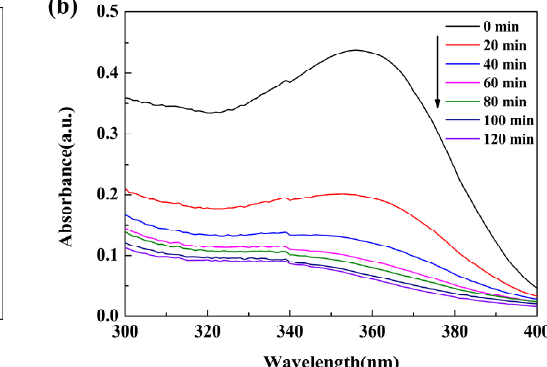
Figure 11. Cycle experiment of 80ZIS/CN photocatalytic degradation of TC. The ∙ OH, h + and ∙ O 2 − produced during the experiment were captured by adding TBA of 0.5 mmol/L, AO of 0.05 mmol/L, and BQ of 0.0126 mg/L into the solution. The result is shown in Figure 12a. When TBA and AO were added to the solution, although the degra ‐ dation effect of TC is slightly lower than that of the blank, the degradation effect of TC is